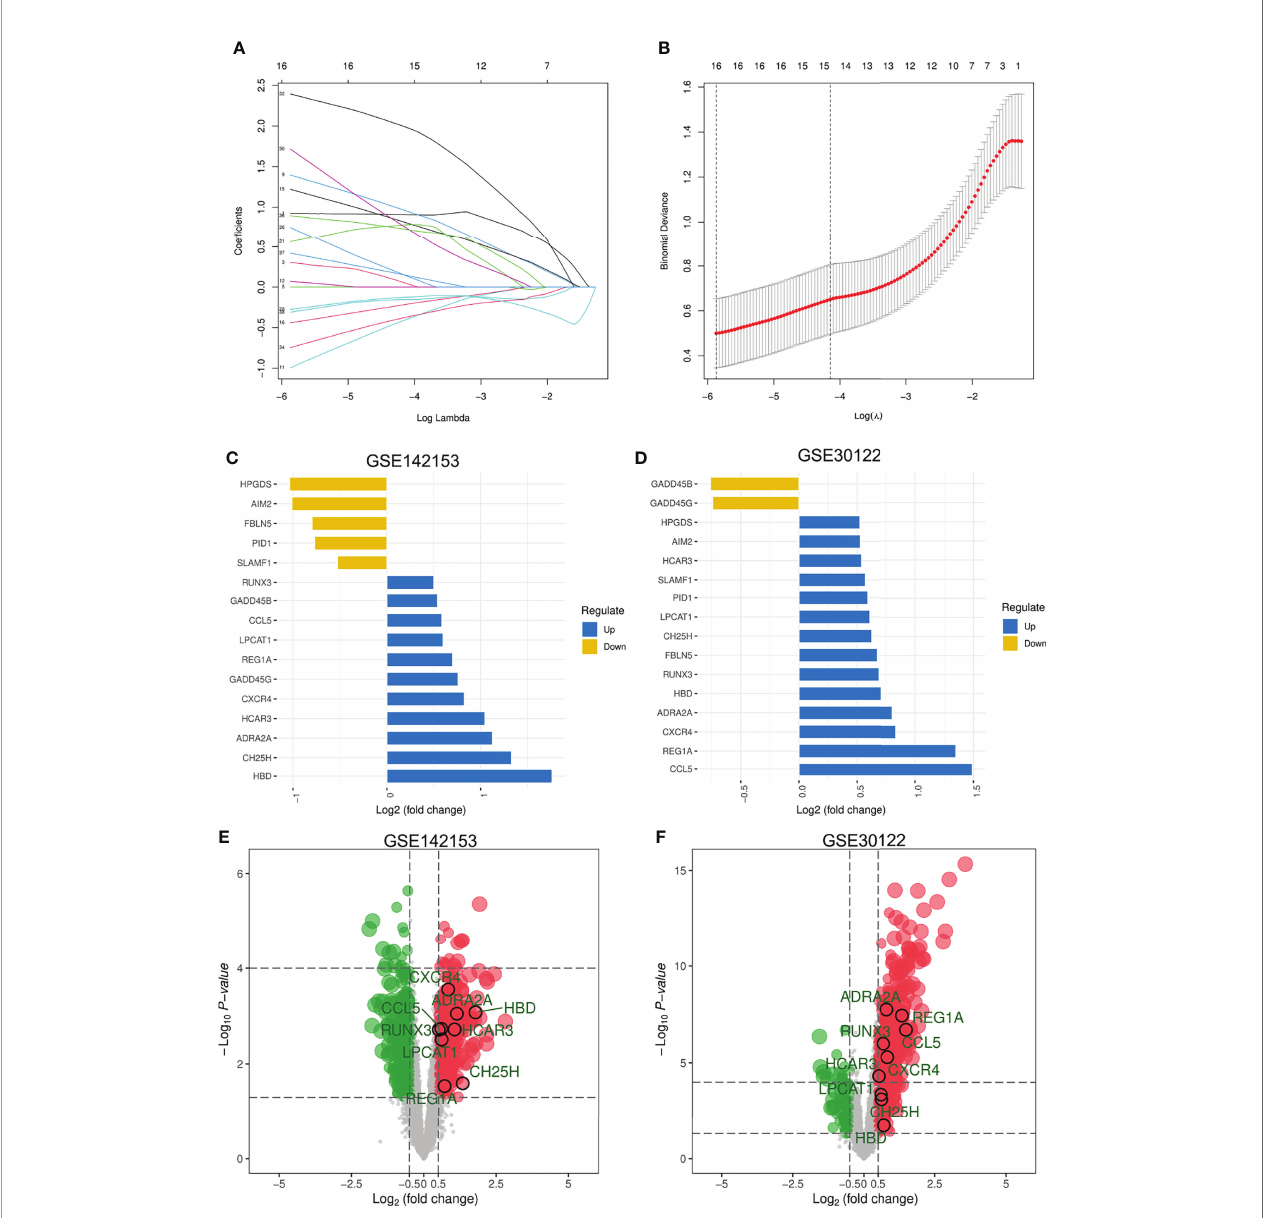
FIGURE 3 | Screening for DEGs with Consistent Expression in DKD Blood and Kidney Samples. (A) LASSO coef fi cient pro fi les of the 38 features. A coef fi cient pro fi le plot was produced against the log( l ) sequence. A vertical line was drawn at the value selected using fi ve-fold cross-validation, where the optimal lambda resulted in 16 features with nonzero coef fi cients. (B) Optimal parameter ( l ) selection in the LASSO model used fi ve-fold cross-validation via minimum criteria. The partial likelihood deviance (binomial deviance) curve was plotted versus log( l ). Dotted vertical lines were drawn at the optimal values by using the minimum criteria and the 1 SE of the minimum criteria (the 1-SE criteria). (C, D) Expression of 16 DEGs in blood and kidney. Five DEGs that were consistently expressed in blood and kidney. (E) Distribution of these 5 DEGs in DKD blood samples. (F) Distribution of the 5 DEGs in the kidney of DKD. LASSO, least absolute shrinkage and selection operator; SE, standard